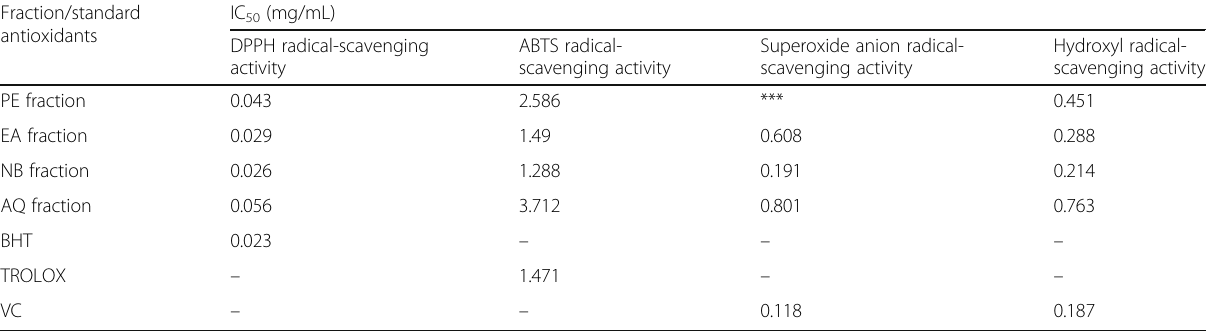
Table 2 In vitro radical-scavenging activities for each fraction isolated from ethanol extract of Lysimachia christinae Hance Fraction/standard antioxidants